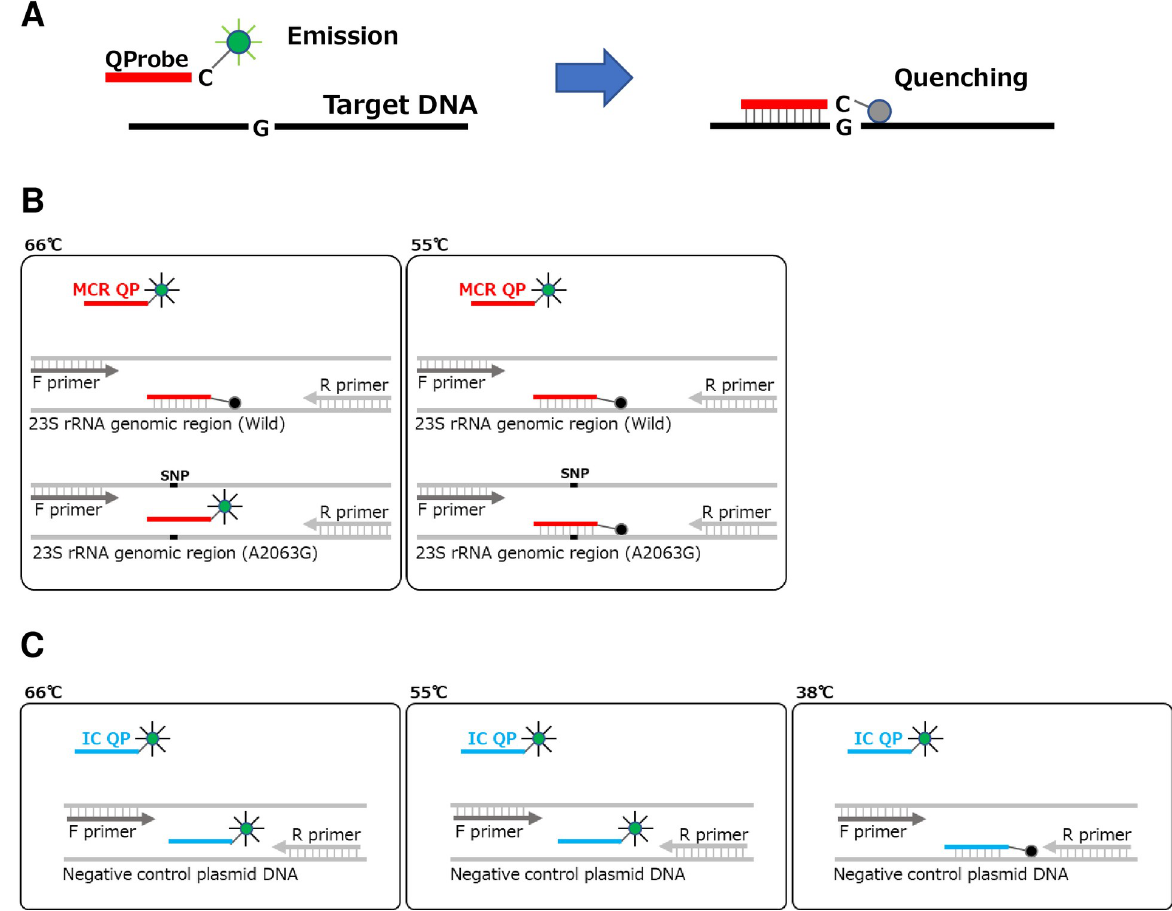
Fig 1. Schematic diagram of the PCR method using QProbe (A) and relationship between temperature and fluorescence intensity in measurements of samples (B) and in tests of internal controls (C).